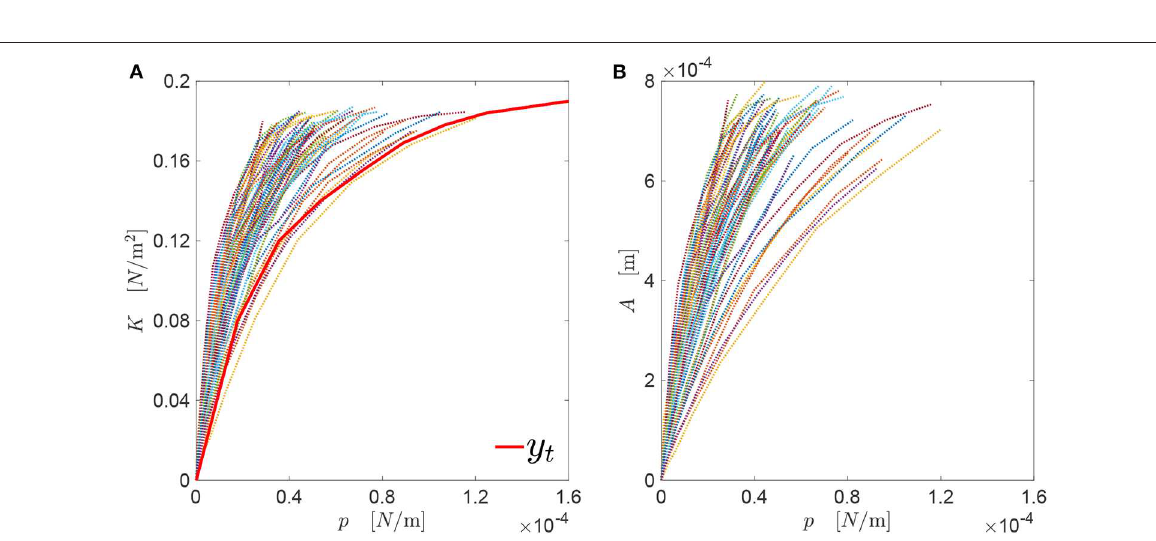
K ( p ) along with all the corresponding curves associated with the genomes in the generated database; (B) all A ( p ) curves associated FIGURE 6 | (A) Target curve y t = with those genomes.